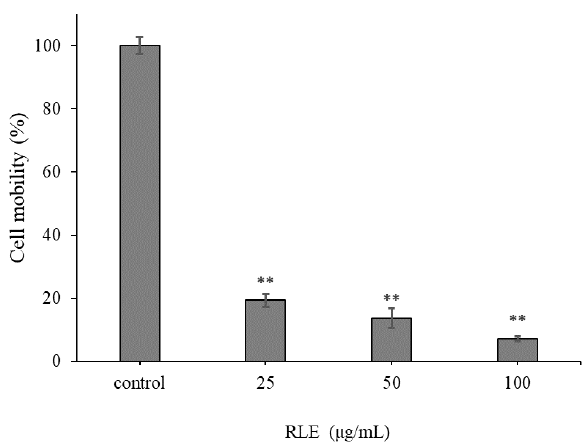
Figure 3. Effect of RLE on the migration of HT-29 cells by wound healing assay.